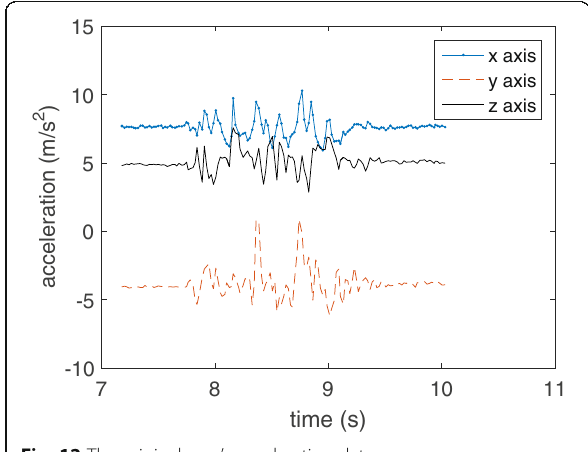
Fig. 12 The original user ’ s acceleration data